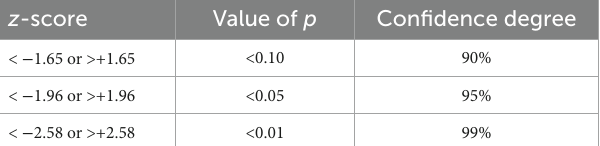
TABLE 2 Global spatial autocorrelation confidence degree